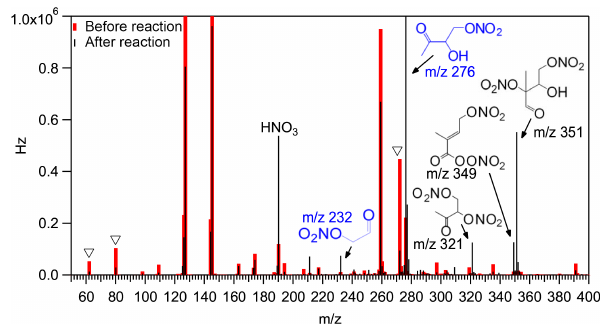
Figure 10. The CIMS spectra before (red) and after (black) the OH + nitrooxy enal oxidation reaction. The inverted triangles show the decreases in CIMS signals for the nitrooxy enal ( m/z 272) and the NO − fragments ( m/z 62, water cluster at m/z 80) derived from 3 the carbonyl nitrate (Fig. 13). The molecular structures are inferred from the nominal masses observed by CIMS. The compounds that were observed by both CIMS and GC (Fig. 13) are colored in